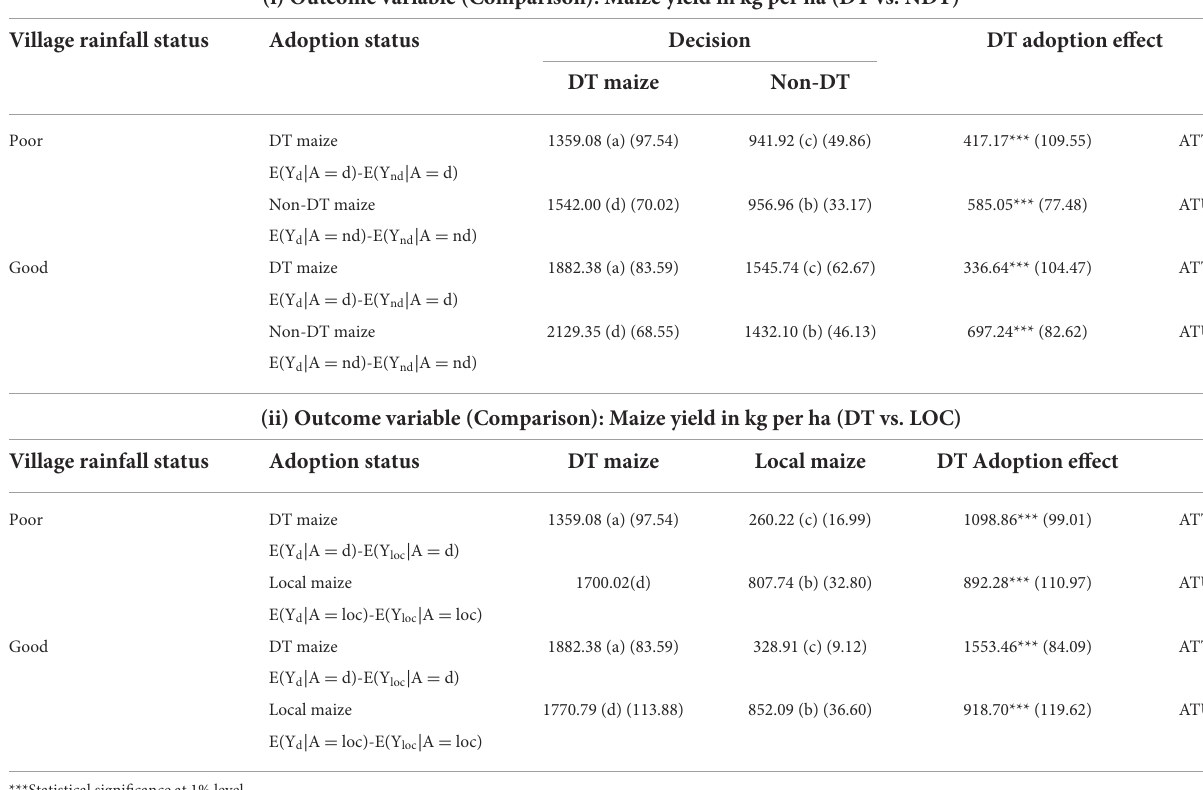
TABLE 6 The average effect of DT adoption by rainfall status of sample villages. (i) Outcome variable (Comparison): Maize yield in kg per ha (DT vs.